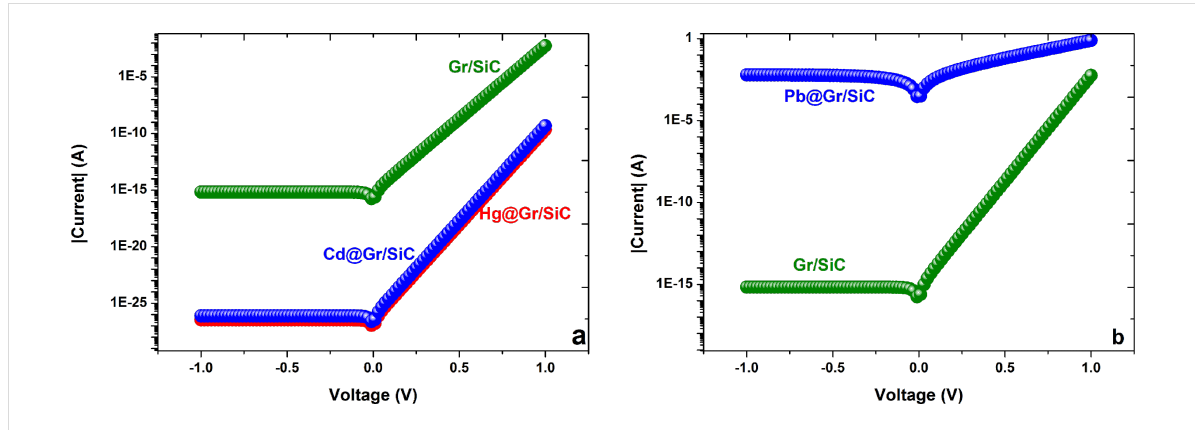
Figure 9: Calculated current–voltage characteristics of the graphene/SiC junction before and after interaction with Cd and Hg (a) and with Pb (b).